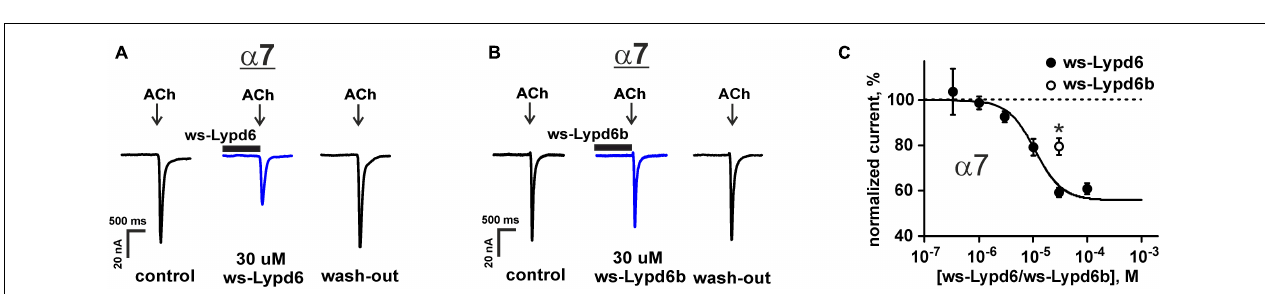
FIGURE 2 | Ws-Lypd6 inhibits homomeric α 7-nAChR expressed in X. laevis oocytes. (A,B) Representative responses to 100 ms pulses of 100 µ M ACh recorded in the presence or absence of 30 µ M ws-Lypd6 or ws-Lypd6b. Pre-incubation time of oocytes with ws-Lypd6 or ws-Lypd6b was 15 s. (C) Dose-response curve for the ws-Lypd6 inhibition of ACh-evoked currents at α 7-nAChRs (closed symbols). The data are normalized to the peak amplitude of current recorded without ws-Lypd6 and ws-Lypd6b (100%) and presented as mean ± SEM ( n = 8 oocytes from 3 animals). The data were fitted by the Hill equation resulted in IC 50 for Lypd6 of 10.9 ± 1.8 µ M, nH of 1.6 ± 0.4, and A 0 of 46 ± 4%. Response to 30 µ M ws-Lypd6b is shown by open symbol ( n = 4 oocytes from 2 animals). * ( p < 0.05) indicates significant difference of ws-Lypd6 and ws-Lypd6b effects ( t -test).